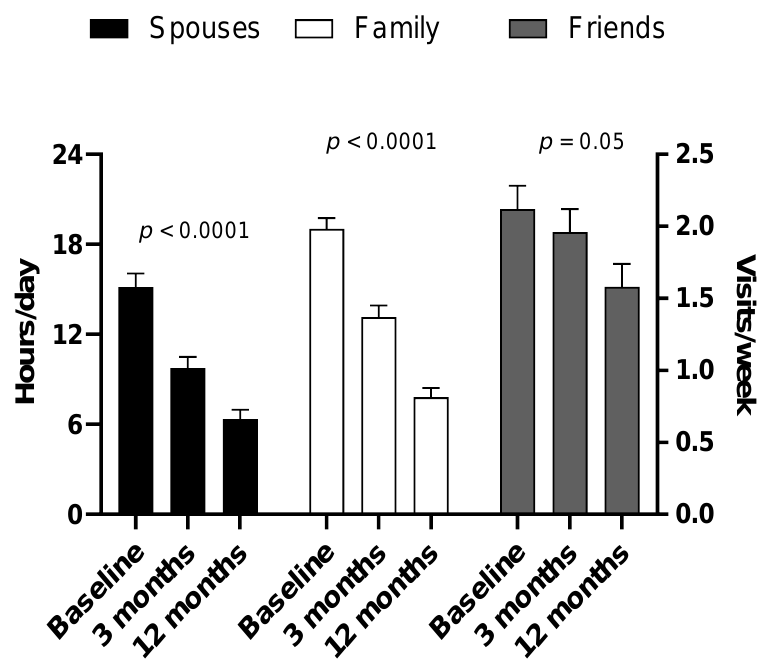
Figure 4. Duration of daily support by family members/spouses (hours/day) and frequency of visits by friends (number of visits/week) to patients at different time points following ICU discharge. Data are presented as mean (SD) values.